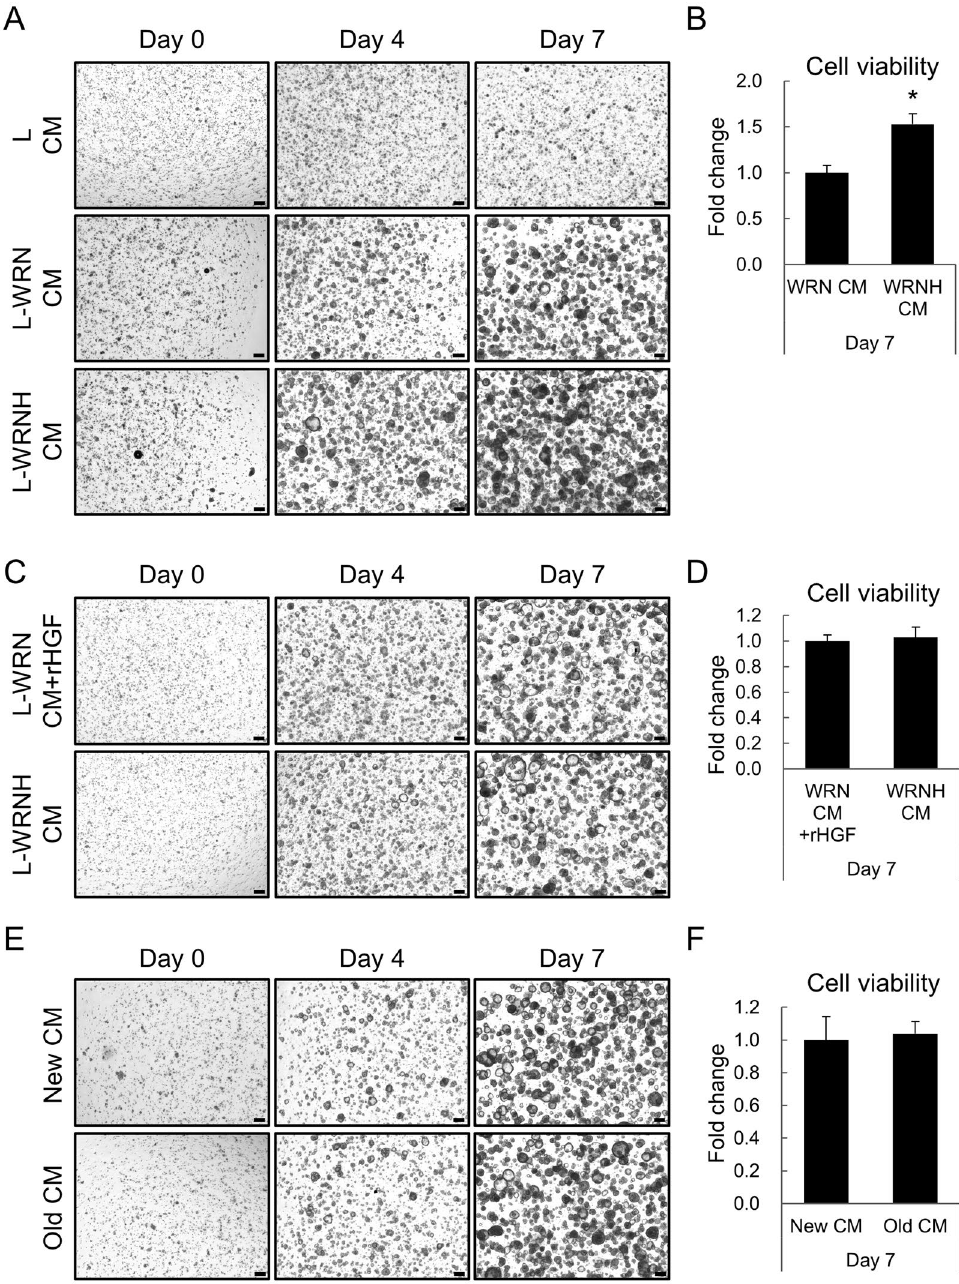
Figure 1. Culture of human intestinal organoids by replacing WRN CM plus recombinant HGF with WRNH CM. ( A–F ) After passage, dispersed hiPSOs embedded in Matrigel were cultured with growth medium containing ( A , B ) 25% intact L CM, 25% L-WRN CM, or 25% L-WRNH CM, ( C , D ) either 25% L-WRNH CM or 25% L-WRN CM plus 50 ng/mL recombinant HGF, or ( E , F ) either 25% L-WRN CM stored at − 80 °C for two years (indicated as "Old CM”) or for two weeks (indicated as “New CM”). ( A , C, E ) After 0, 4, and 7 days of culture, the cells were observed with bright field microscopy. A series of z-stack images were then processed to acquire each full-focused image. Scale bar, 200 μm. ( B , D, F ) After 7 days of culture, the cells were harvested with TrypLE Express solution and resuspended with basal medium. The number of viable cells was determined using CellTiter-Glo 3D reagents. Assays were performed in n = 4 biologically independent replicates (mean ± S.D.). * P <